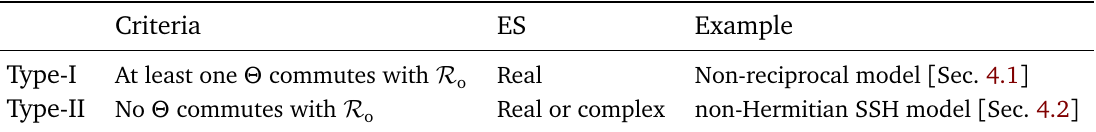
Table 1: Criteria and entanglement spectrum (ES) for categorizations on non- Hermitian free systems as well as two examples. We obtain two types of non- Hermitian free systems according to whether at least one Θ in Eq. (8) exists to com- mute with a real space partition . R o Criteria ES Example Type-I At least one Θ commutes with Real R o No Θ commutes with Real or complex non-Hermitian SSH model [ Sec. 4.2 R o